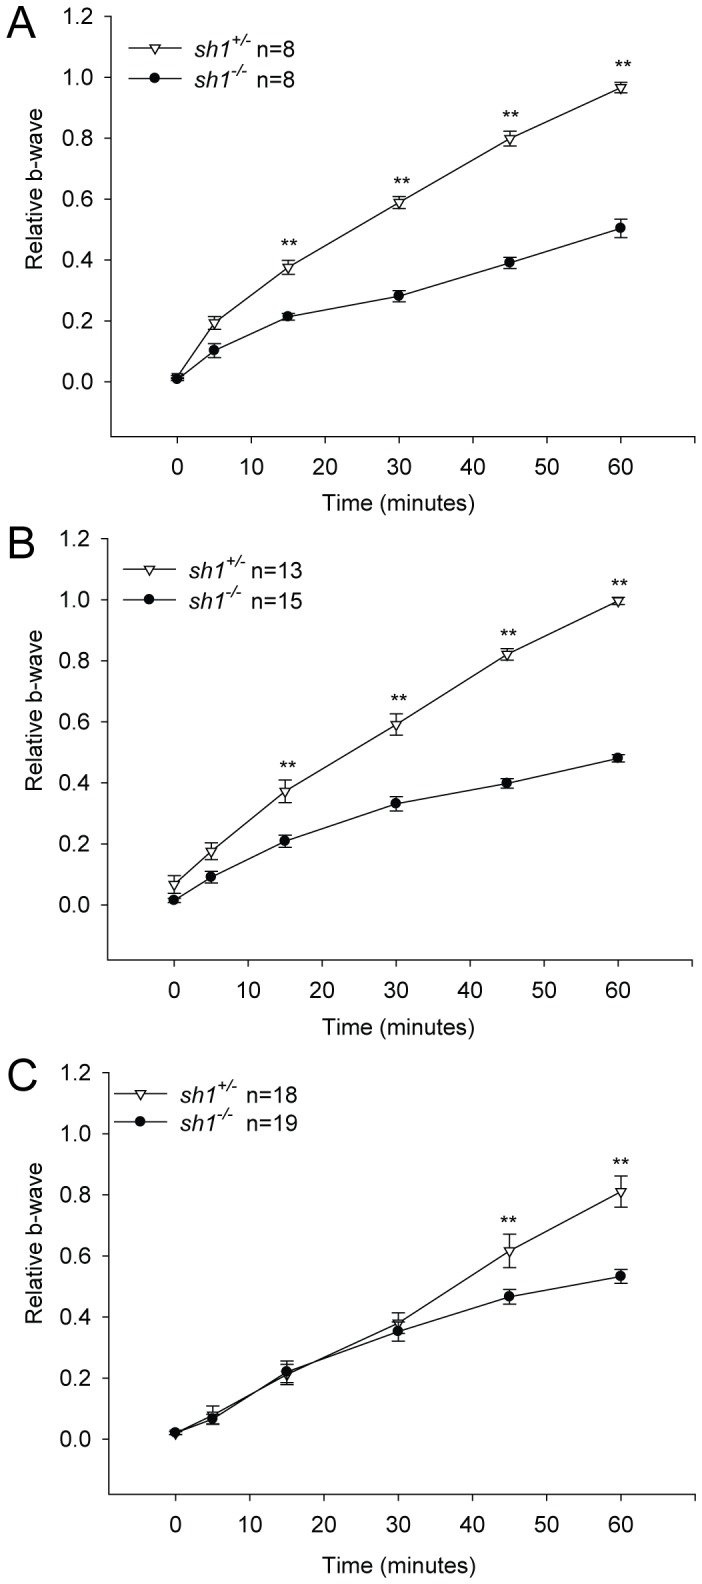
Retinal recovery from light desensitization in albino sh1 mice. The relative b-wave is the ratio between the post- and the pre-desensitization b-wave amplitudes (µV) both evoked by 1 cd*s/m2. The time (minutes) refers to the time post-desensitization. Data are from sh1 mice at 2 (A), 6 (B) and 12 (C) months of age. Data are presented as mean±SEM; n indicates the number of eyes analyzed. To assess statistical significance Gaussian Processes Bayes Factor (BF) and ANOVA p value were calculated: BF>>1 (A–C), p<<2×10−16 (A–B), p = 5.3×10−6 (C). The statistical significant differences between sh1+/− and sh1−/− mice at each specific time are marked by asterisks: **p value<0.05, **p value<0.001. More details on the statistical analysis including specific statistical values can be found in the Statistical analysis paragraph of the Materials and Methods section.